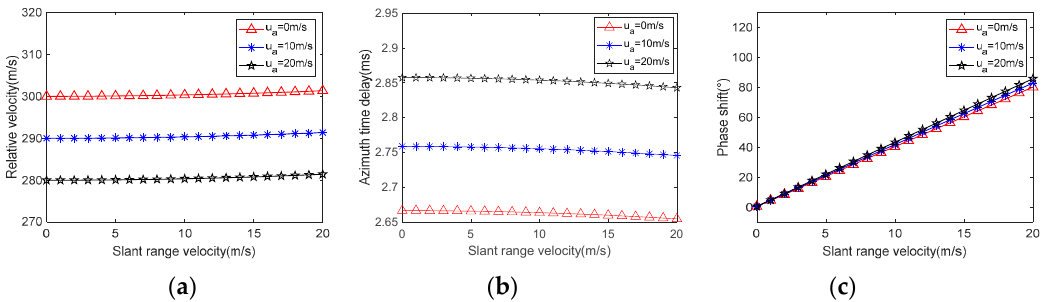
Figure 4. Effects of the slant range velocity on different azimuth multichannel parameters in the multichannel GEO-SA-BiSAR system. ( a ) Relative sensor velocity. ( b ) Azimuth time delay. ( c ) Phase shift.